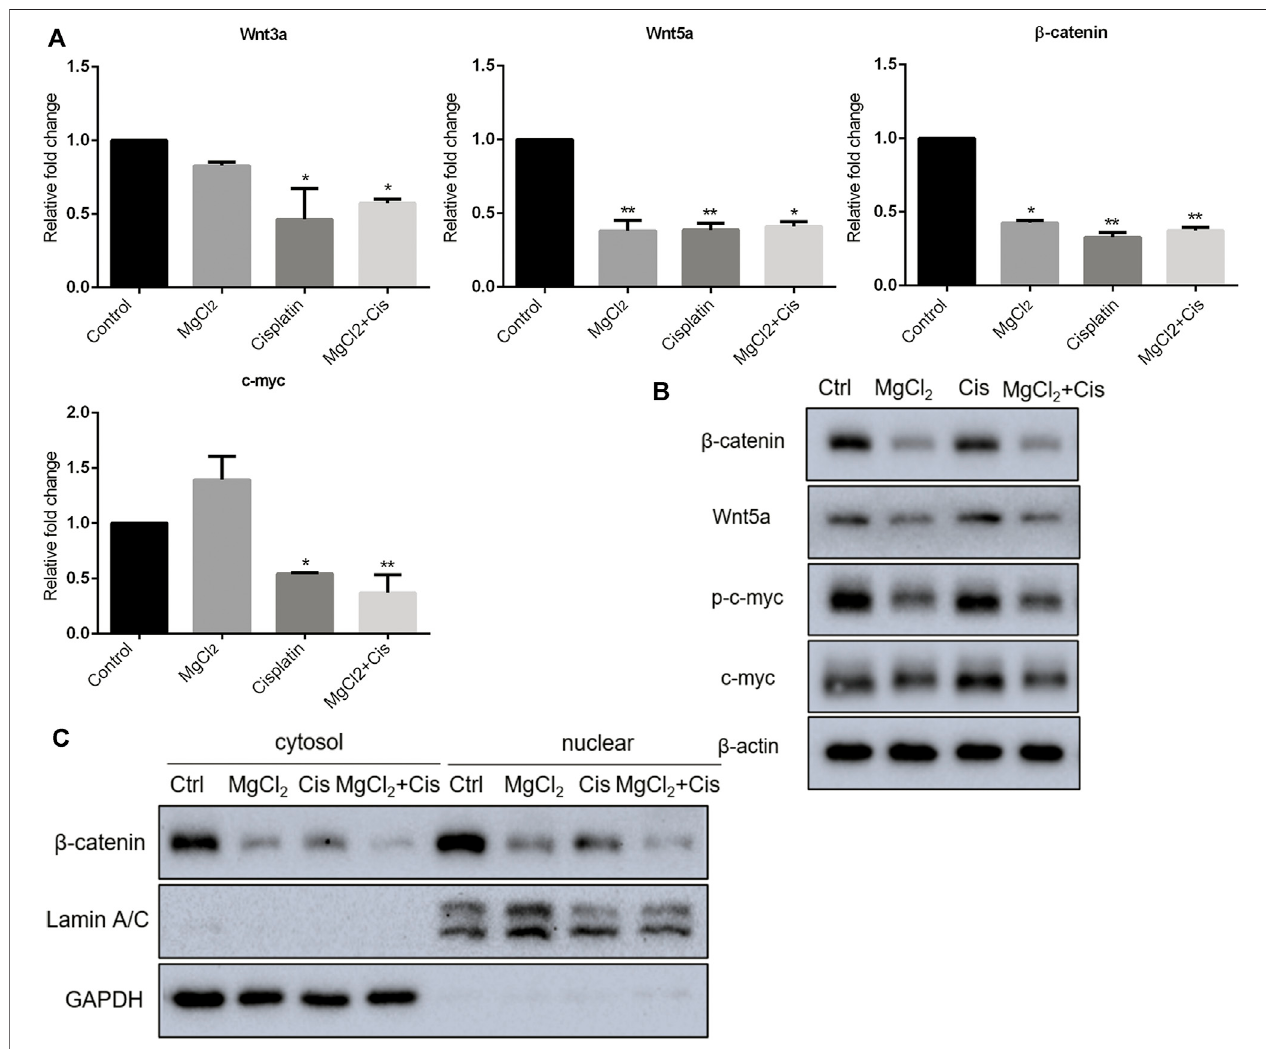
FIGURE 4 | Expression of Wnt/ β -catenin signaling components in UC3 bladder cancer cells received combinatorial treatment with MgCl 2 and cisplatin (Cis). (A) Geneexpressionwasdetermined byqPCR(mean ± SEMofduplicateexperiments).* p < 0.05vs.controland** p < 0.01versuscontrol. (B) Proteinexpression ofWnt/ β - catenin signaling components and p-c-myc were assessed by western blot. (C) Protein expression of nuclear and cytosol β -catenin as evaluated by western blot. Densitometry of western blot was showed in Supplementary Figure S8 .